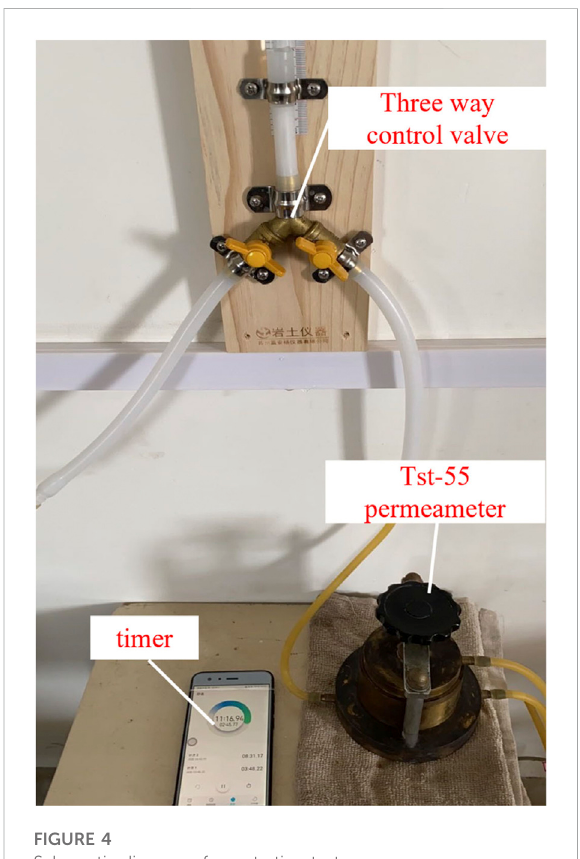
FIGURE 4 Schematic diagram of penetration test process.